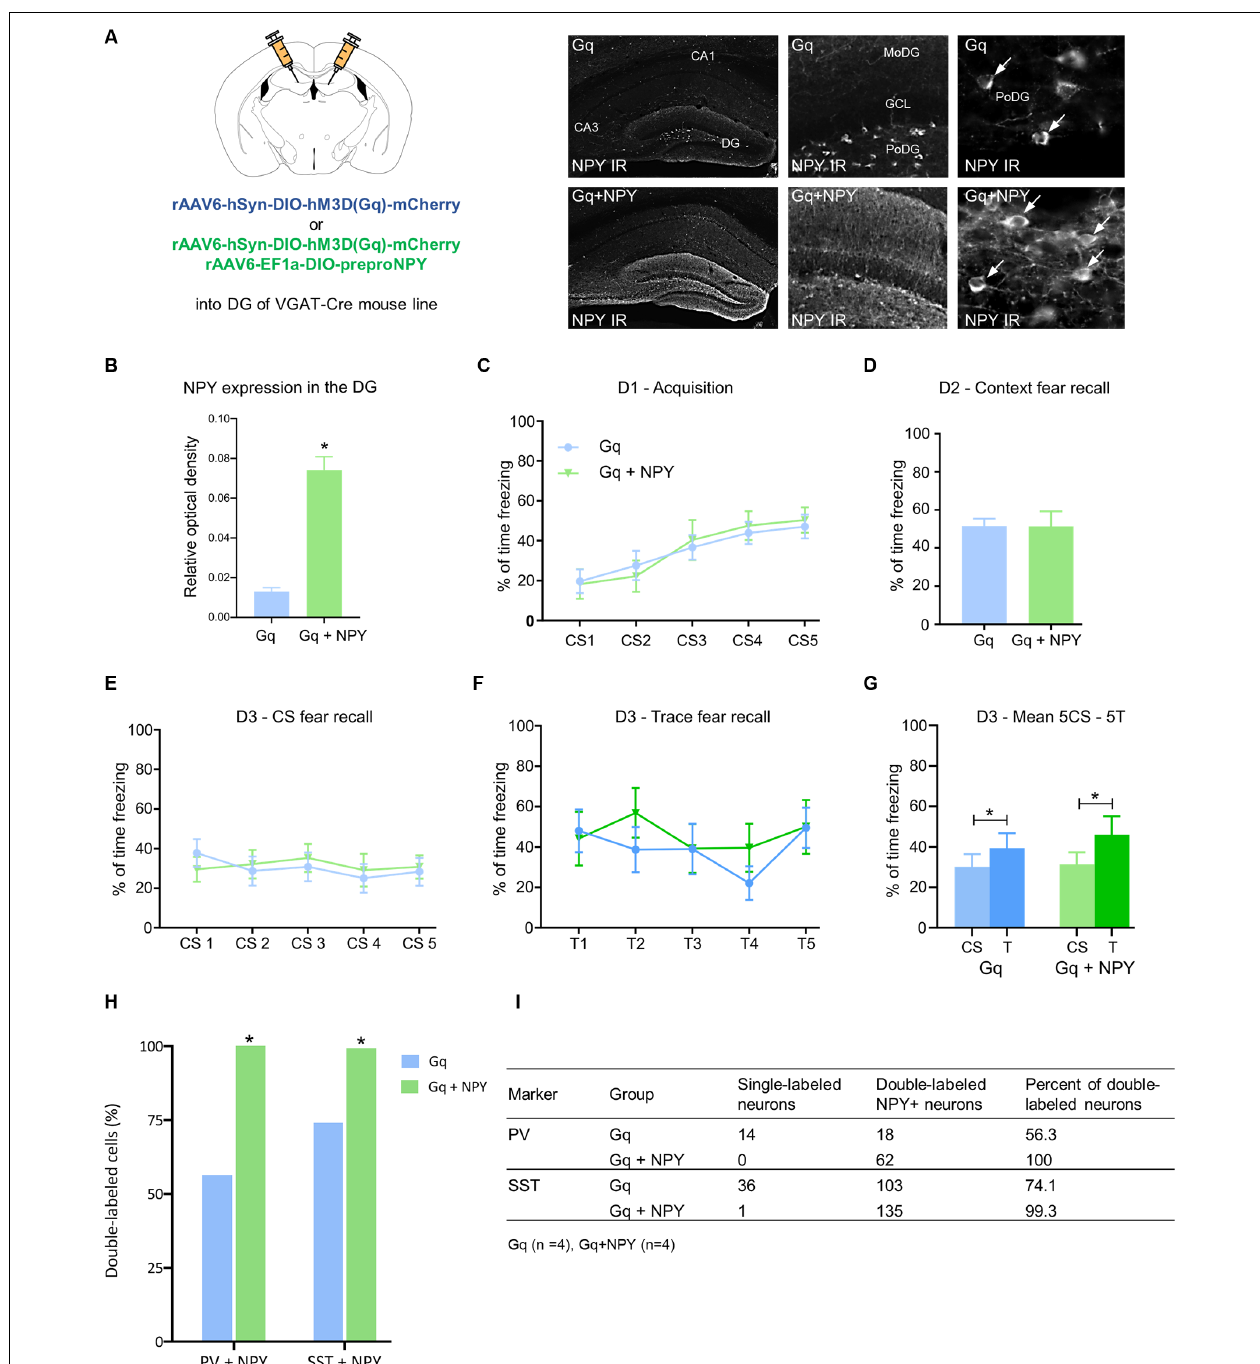
FIGURE 2 | Overexpression of neuropeptide Y (NPY) in dentate gyrus GABA neurons does not further reduce CS-related and trace-related fear expression upon chemogenetic activation. (A) Photomicrographs of NPY immunohistochemistry in coronal mouse brain sections and quantification of relative optical density (ROD) demonstrate higher expression of NPY in the dorsal hippocampus of mice injected with rAAV-hSyn-DIO-hM3DGq-mCherry/rAAV-EF1a-DIO-NPY (Gq + NPY) than those injected with rAAV-hSyn-DIO-hM3DGq-mCherry (Gq) alone. (B) Increased expression of NPY-IR in the dorsal DG of a Gq + NPY injected mice compared to Gq injected controls. (C) No change in percentage of freezing during fear acquisition on day 1 (D1) and (D) equal freezing during contextual fear testing on day 2 (D2). (E) Similarly, there was no difference in freezing time during the CS and (F) trace period on day 3 (D3) following injection of CNO to activate dentate GABA neurons. (G) Both, Gq and Gq + NPY injected mice showed higher freezing during trace than during CS-period. (H) Quantification of dual-immunofluorescence demonstrating increased expression of NPY-IR in parvalbumin (PV) and somatostatin (SST) neurons of the dorsal DG of Gq + NPY mice compared to Gq-injected controls. (I) Tabular results for individual groups of DG interneurons in Gq + NPY and Gq mice. Data are presented as means ± SEM, * P < 0.05. Gq: n = 14, Gq + NPY: n = 11.